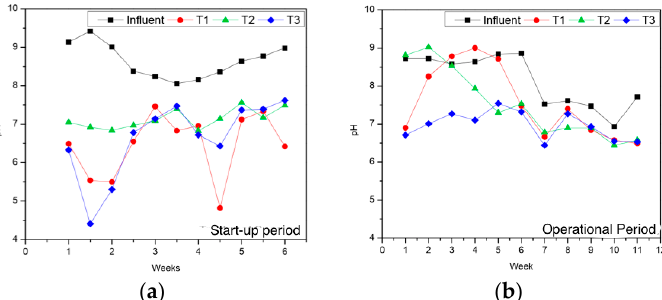
Figure 3. ( a ) pH variation over start-up experimental period; and ( b ) pH variation over operational experimental period.